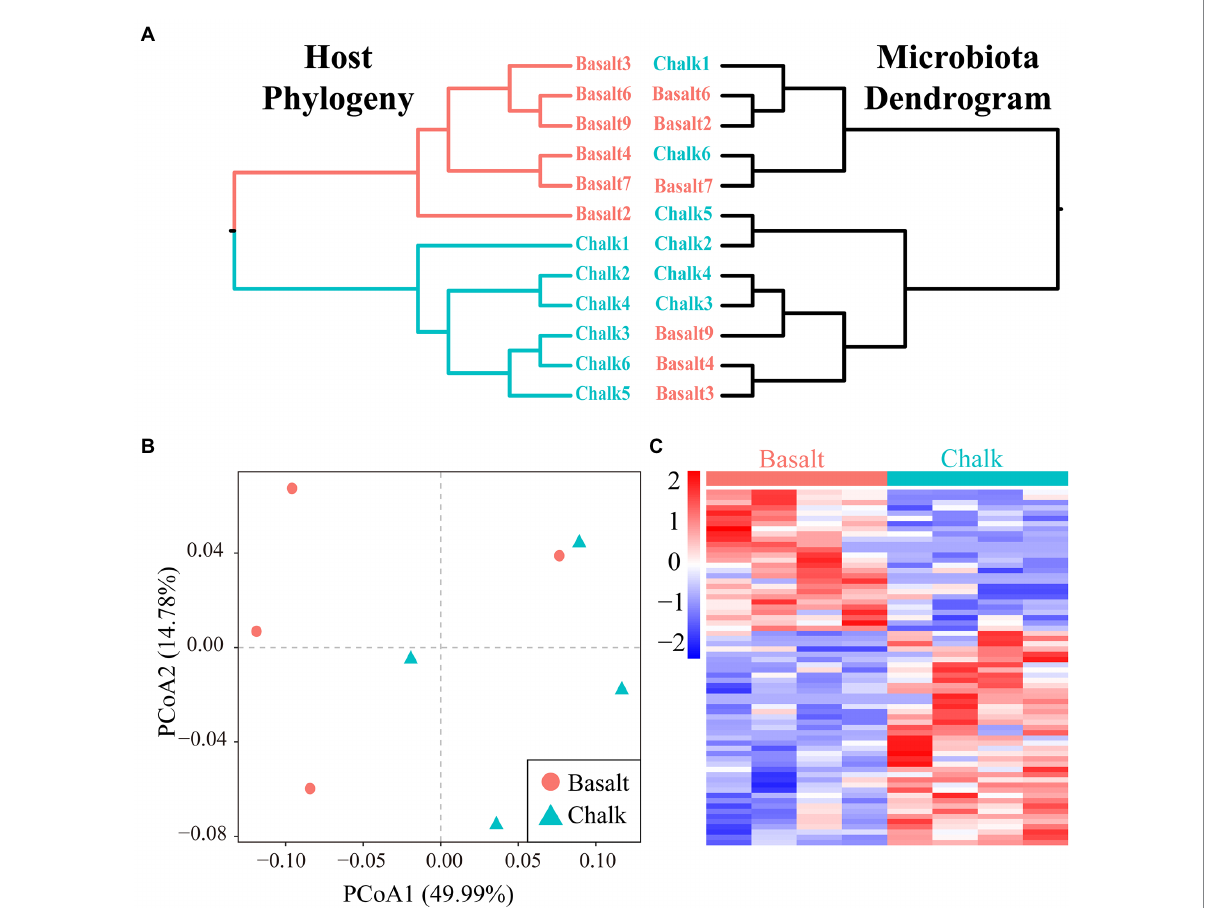
FIGURE 5 Host divergence and the correlation with its gut microbiome. (A) Host phylogeny and microbiota dendrogram were not mirroring each other. (B) Principal component analysis showed that the protein composition of basalt and chalk did not differ significantly. (C) Abundance clustering Heatmap of 127 differential